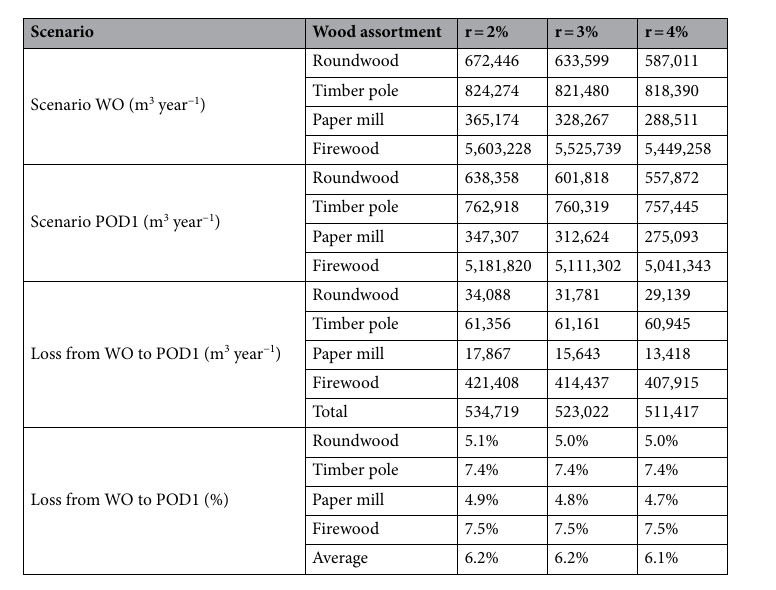
Table 3. Timber production under no ozone damage scenario (WO) and phytotoxic ozone dose (POD1) scenario in Italy in 2005 and potential losses, with different interest rates r.